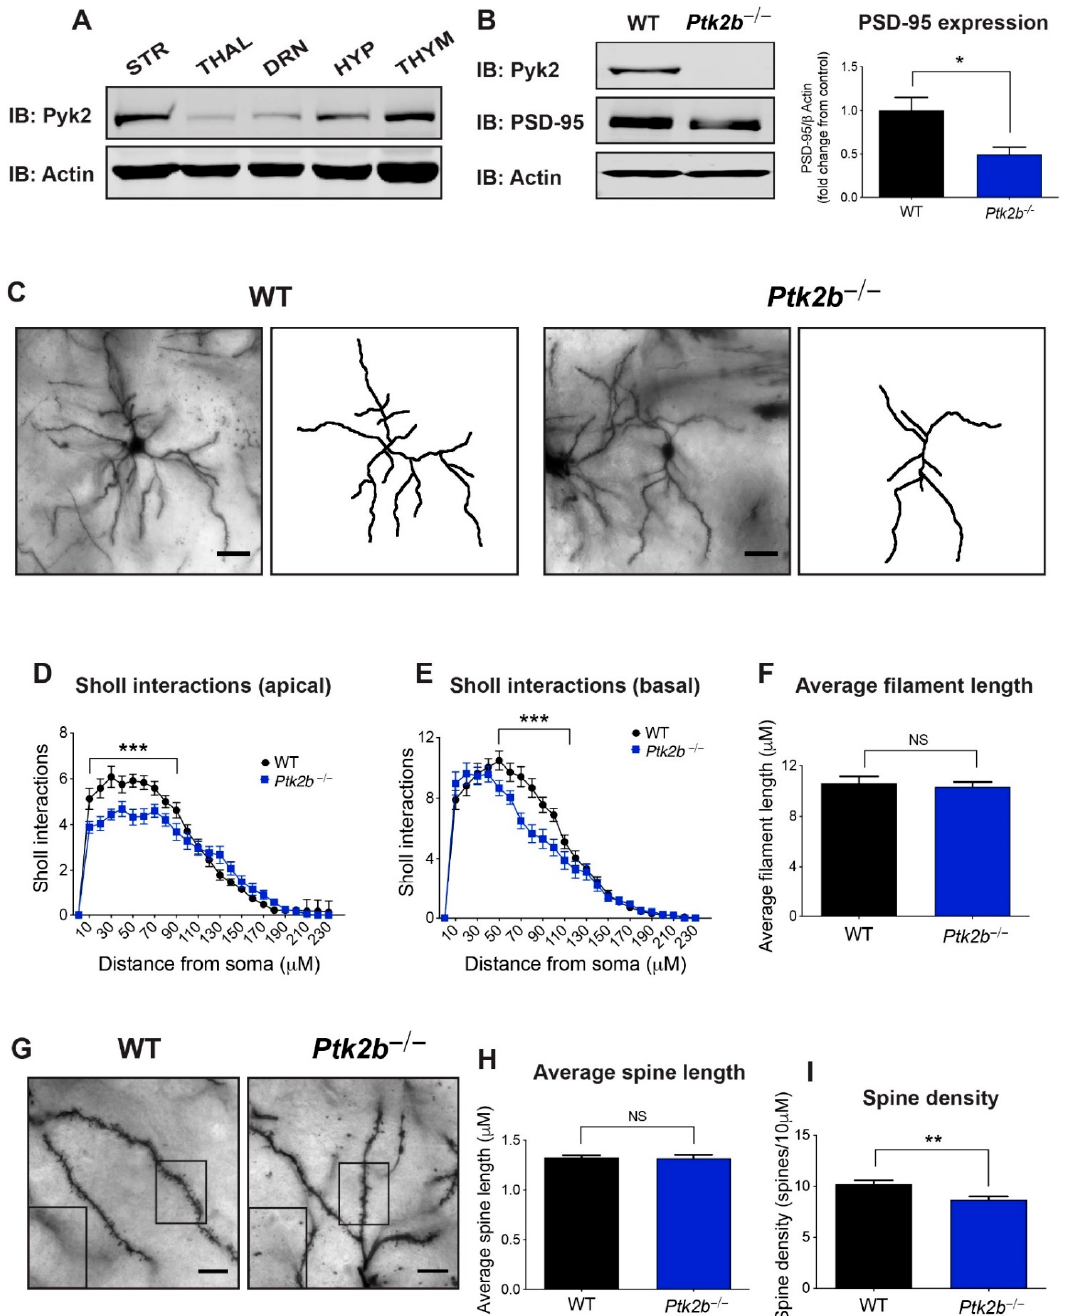
Figure 1. Pyk2 ensures complex dendrite arbors and spines on medium spiny neurons of the DMS. ( A ) Immunoblot analysis of Pyk2 in striatum (STR) compared to other brain regions: thalamus (THAL), dorsal raphe nucleus (DRN), hypothalamus (HYP), and to the thymus, a hematopoietic organ where Pyk2 is highly expressed (THYM). n = 3 mice per group. ( B ) Left, representative immunoblots of Pyk2 and PSD-95 levels in WT and Ptk2b − / − striatum. Right, quantification of PSD-95 protein levels. n = 3 mice per group. ( C ) Representative Golgi-Cox images and tracing of WT ( left ) and Ptk2b − / − ( right ) medium spiny dorsomedial striatal neurons. Scale bar, 25 µ m. ( D , E ) Apical ( D ) and basal ( E ) Sholl interaction analysis of dorsomedial WT and Ptk2b − / − striatum neurons. n = 28 neurons from 4 mouse brains. ( F ) Average filament length of WT and Ptk2b − / − dorsomedial spiny neurons. ( G ) Representative Golgi-Cox images of dendritic spines from WT and Ptk2b − / − medium spiny neurons. Scale bar, 10 µ m. ( H , I ) Quantification of dendritic spine length ( H ) and density ( I ) on medium spiny neurons from WT and Ptk2b − / − dorsomedial striatum. n = 18 dendrites from 4 mouse brains, * p < 0.05, ** p ≤ 0.01, *** p ≤ 0.001. NS, non-significant. Error bars represent